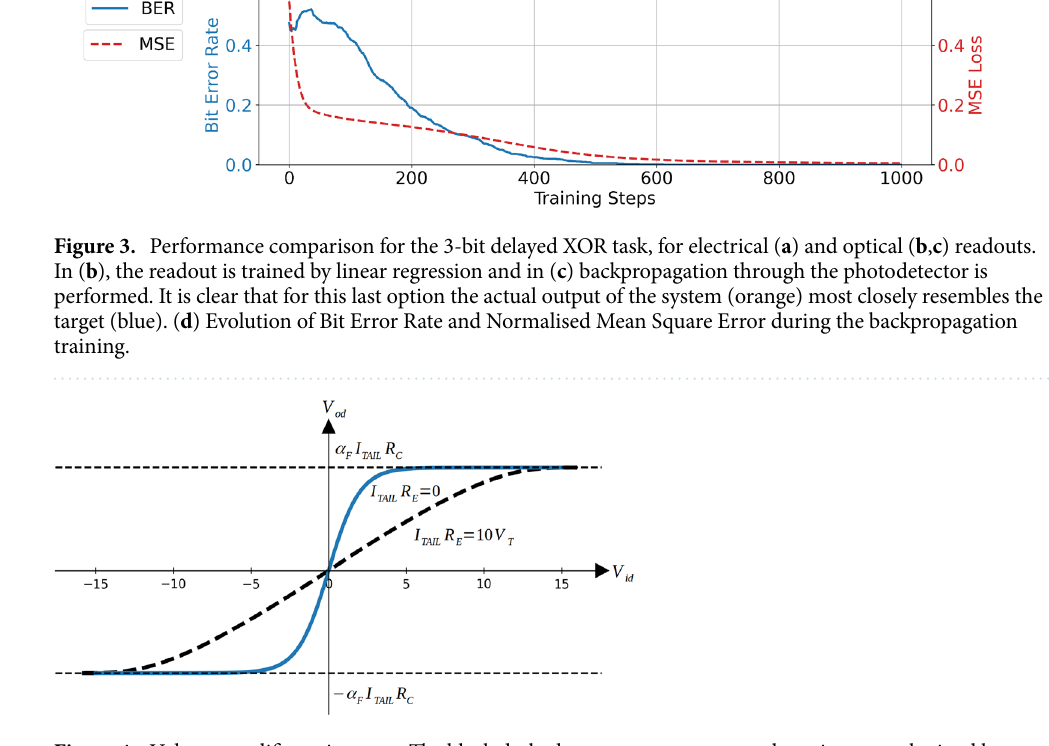
Figure 4. Voltage amplifier gain curve. The black dashed curve represents a regular gain curve obtained by using emitter-degeneration resistors R E . The blue curve represents the initial gain curve without an emitter- degeneration